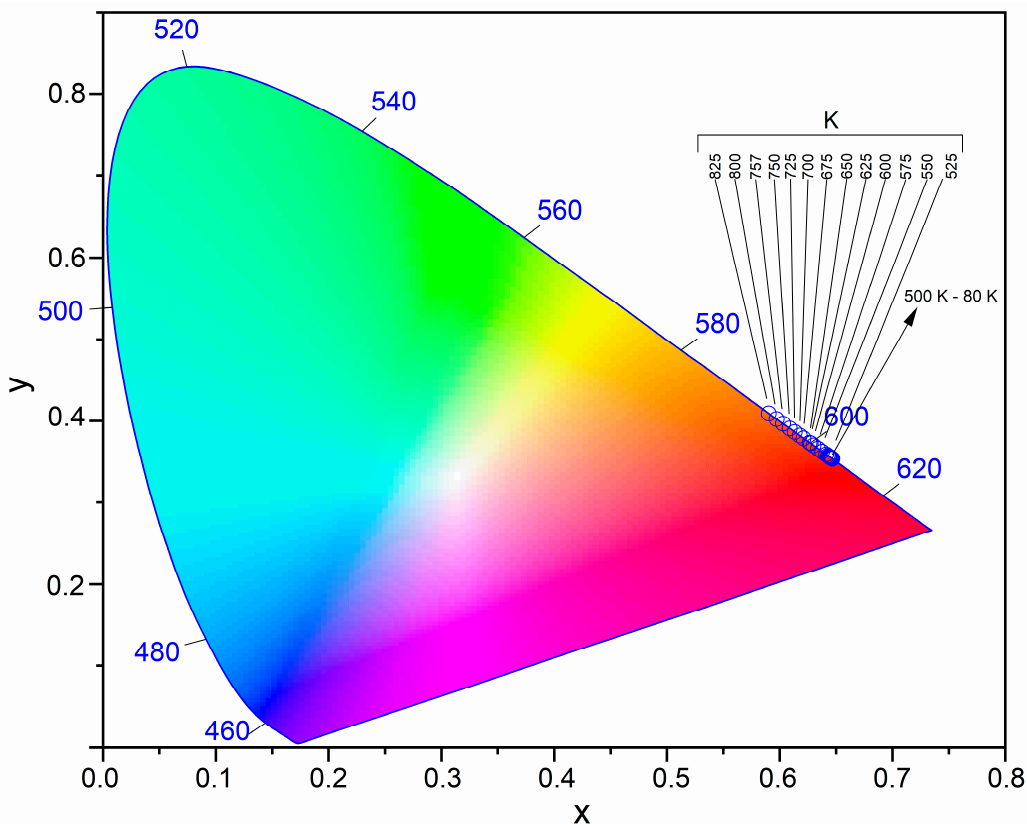
Figure 8. CIE 1931 chromaticity diagram of the Ca 9.6 Sr 0.2 Eu 0.2 (PO 4 ) 2 (SiO 4 ) 4 (OH) 2 as a function of ambient temperature.